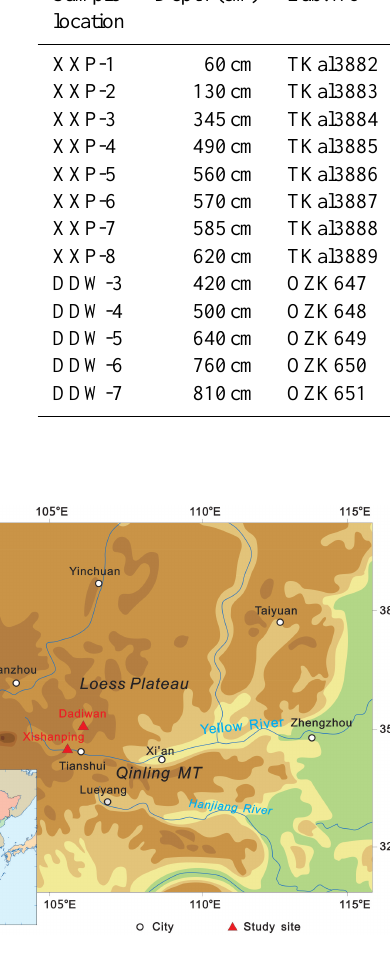
Fig. 1. Location of the study